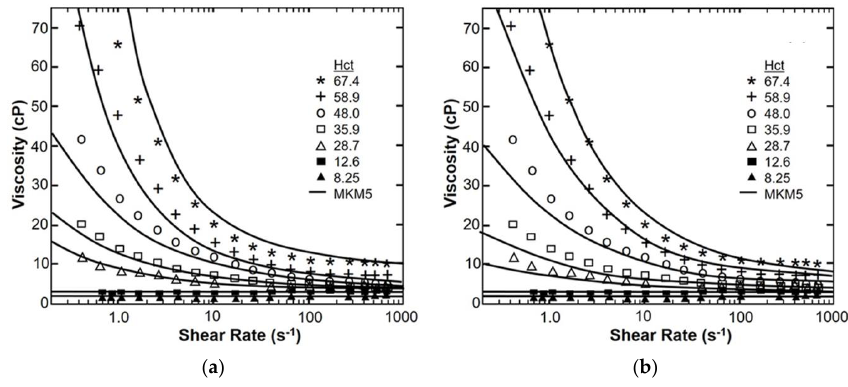
Figure 3. A comparison of shear thinning according to the MKM5 ( a ) and the Quemada model ( b ) vs. the experimental data of Brooks et al. [49] (symbols) for seven values of hematocrit and spanning four decades of shear rate.